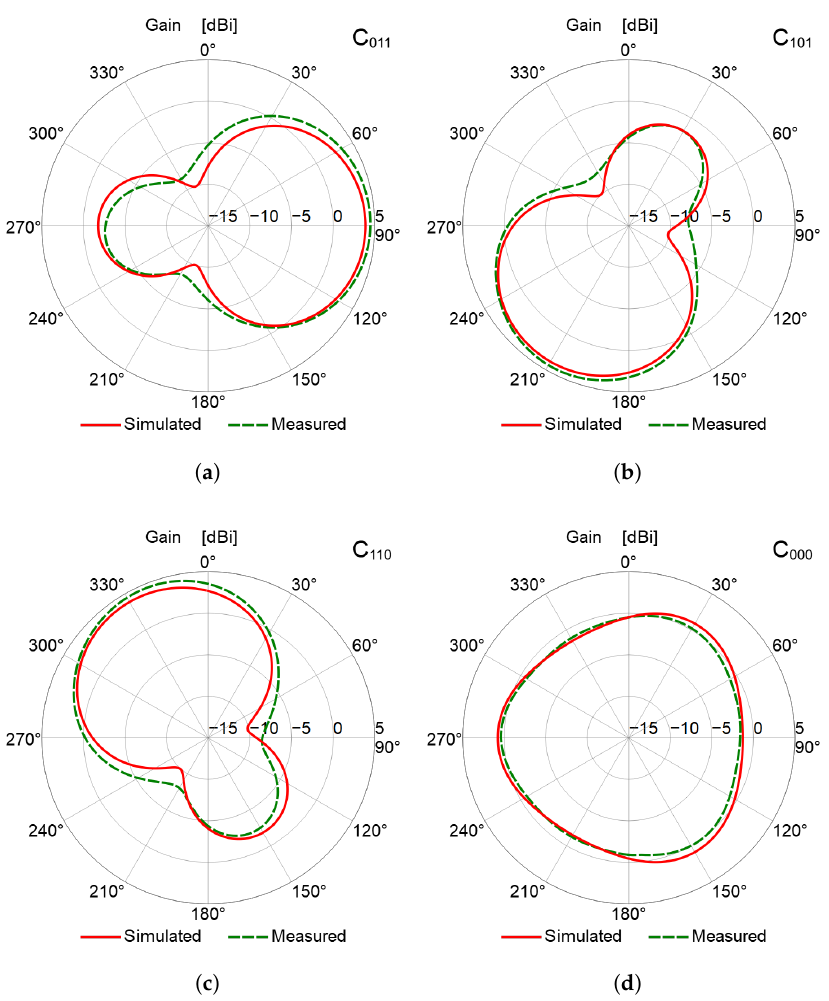
Figure 3. Simulated and measured realized gain patterns in the horizontal plane for the different switch configurations. ( a ) C 011 , ( b ) C 101 , ( c ) C 110 , and ( d ) C 000 .